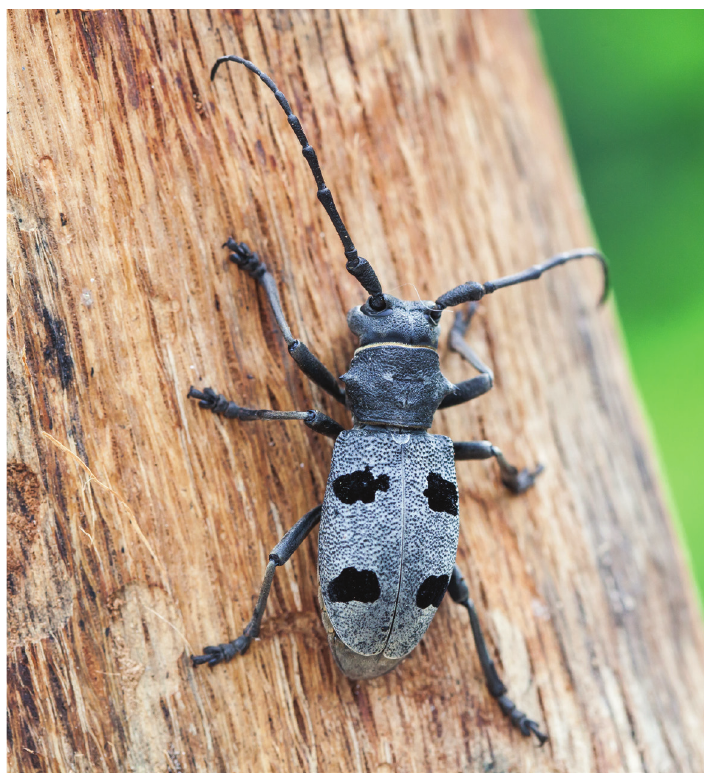
Figure 3. Morimus asper funereus (Photo by Kajetan